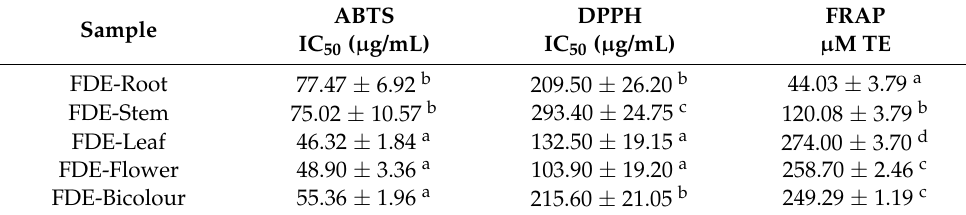
Table 3. Antioxidant activity and IC 50 of FDE from P. peltatum . Sample